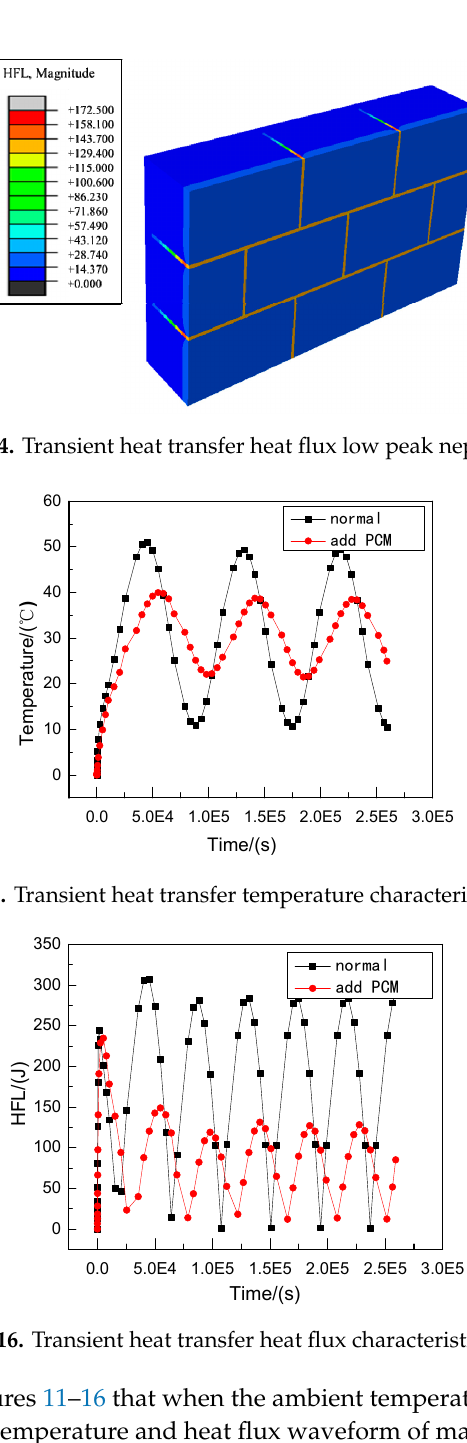
Figure 13. Transient heat transfer heat flux peak nephogram.